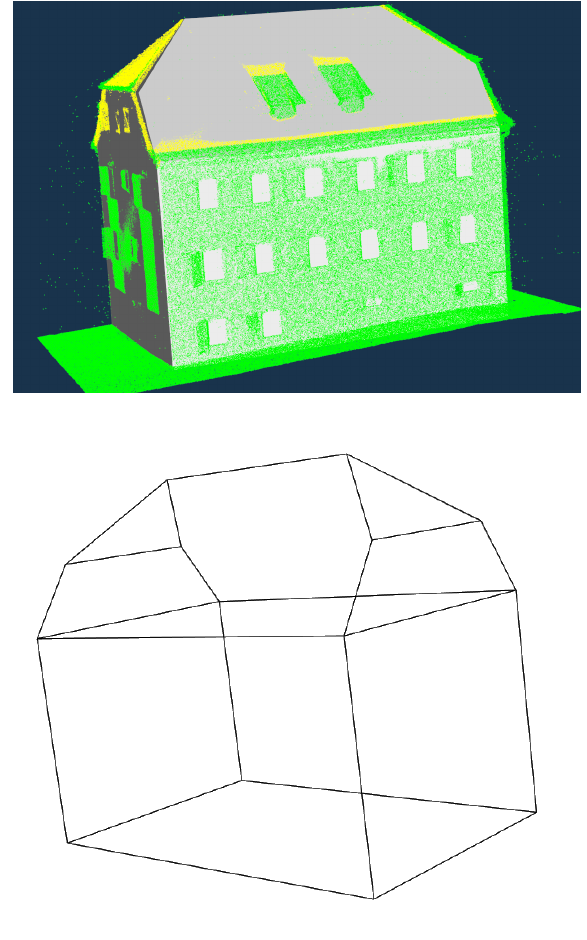
Figure 5. LOD 2 building model. Surfaces of roof model and 3D points in the same view with the model supporting points in yellow and others in green (top), and wireframe model of the same building (below).